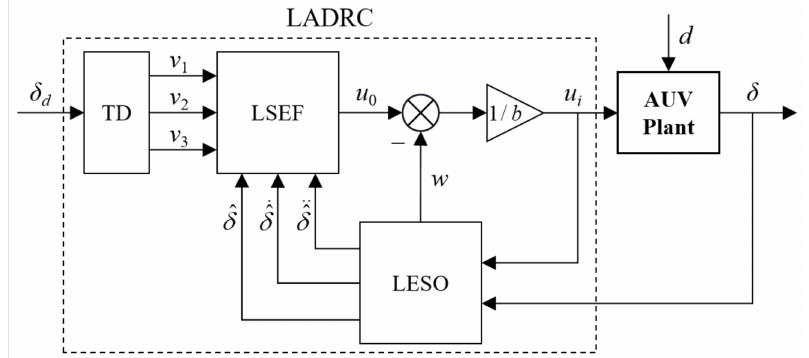
Figure 4. Diagram of the third order LADRC